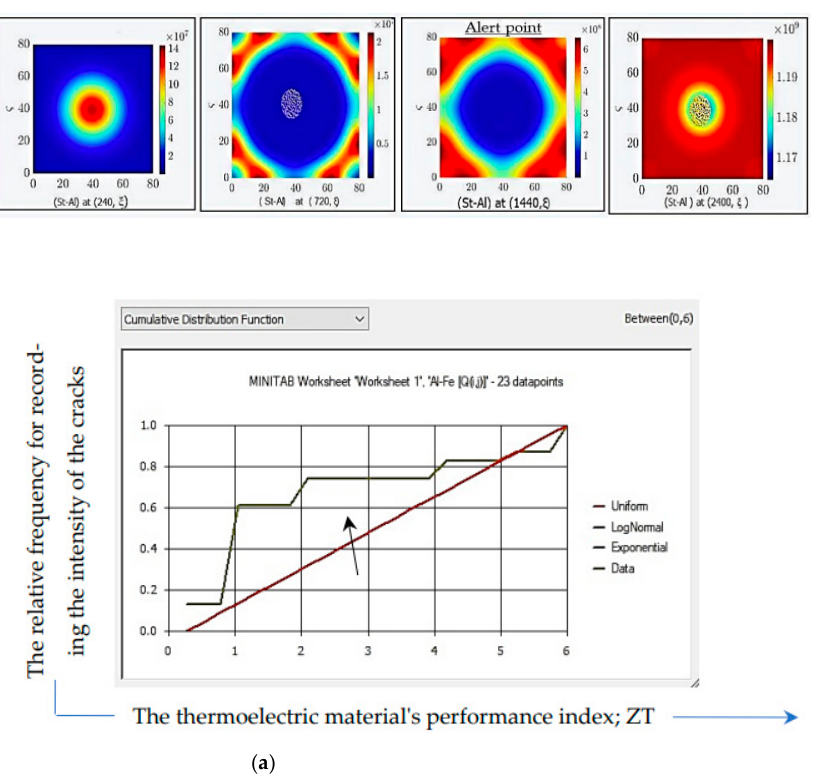
gasket and TEG legs to save the thermal conductors via 𝑃 (cid:3036) − and 𝑄 (cid:3017) -like uniform distri-